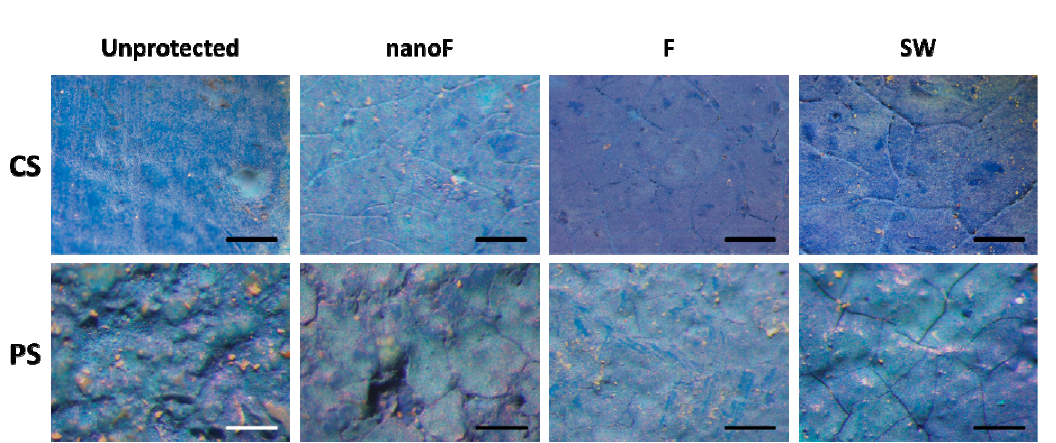
Figure 10. Images taken by the stereomicroscope of the surfaces stained by felt-tip marker: comparison between the protected and unprotected surfaces (CS = compact stone; PS = porous stone). Each scale bar indicates 200 µm.